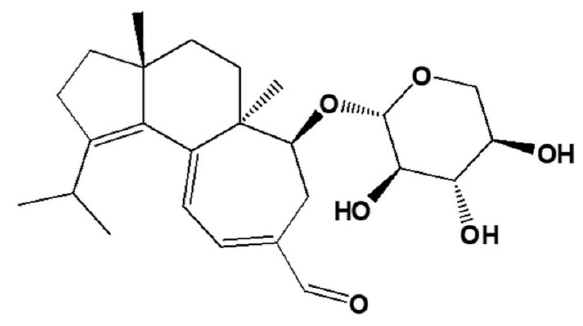
Figure 5. Erinacine A